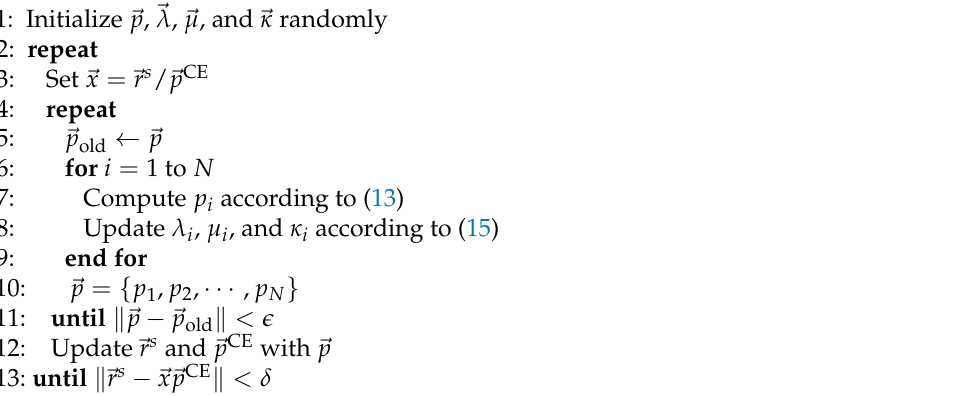
Algorithm 1 Proposed energy-efficient transmit power control